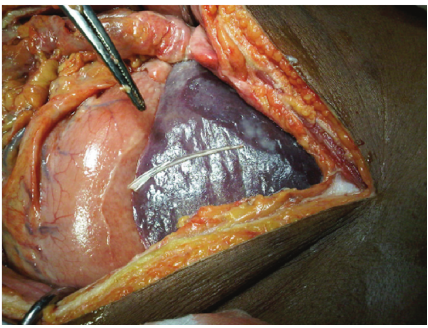
Figure 1: Fish bone extracted from abscess